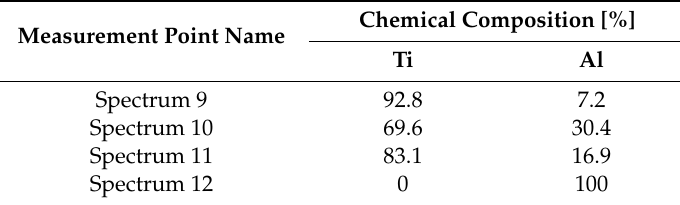
Table 4. Results of chemical composition measurements in the connection zone of the Ti6Al4V and AA1050 aluminum alloys.